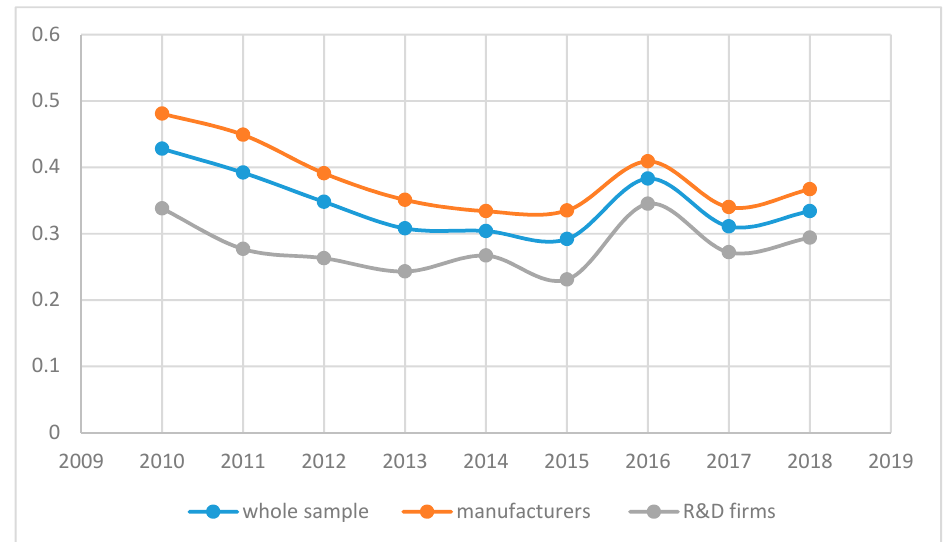
Figure 3. Efficiency in the pharma and biotechnological European industry by main activity, 2010–2018. Note: the figure summarizes the yearly trend of average efficiency, for the whole sample and disaggregated by categories corresponding to the main activity of firms. Efficiency decreases over the period, with a partial recovery in 2015–2016. Source: own elaboration.